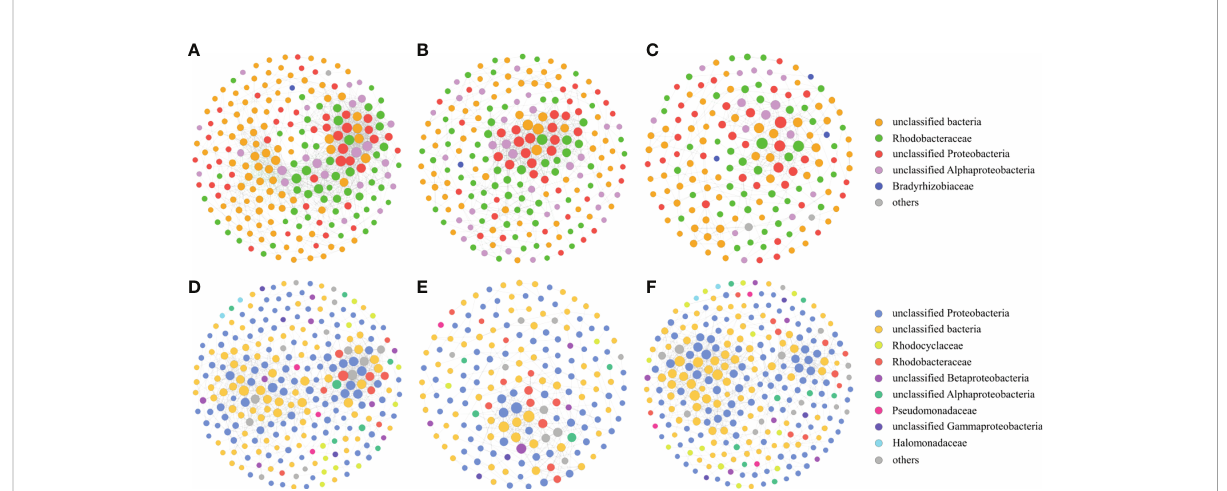
FIGURE 8 Co-occurrence networks of the nirK -type denitrifying bacteria during the green tide (A) , the outbreak phase (B) and the decline phase (C) , and co-occurrence networks of the nirS -type denitrifying bacteria during the green tide (D) , the outbreak phase (E) and the decline phase (F)